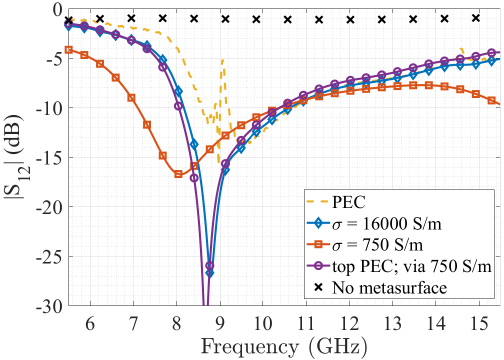
Figure 7. Simulated transmission coefficient | S 12 | as a function of the frequency of the parallel plate with a 3 × 4 mushroom metasurface, using different conductive materials for the